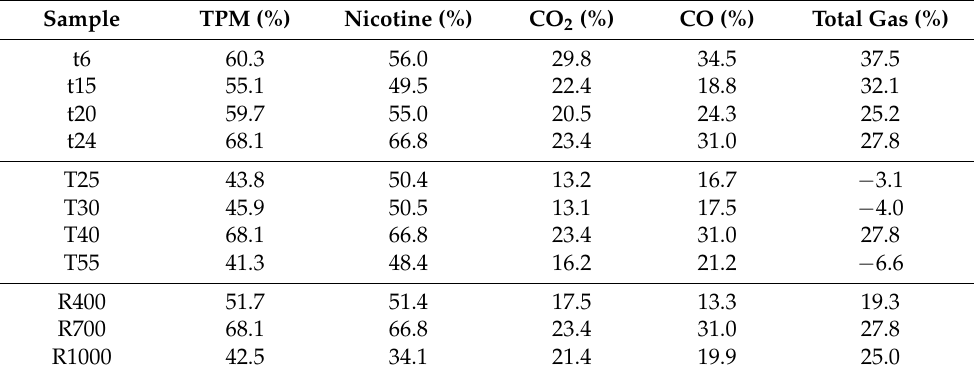
Table 2. Smoking experiments results. Reduction of total particulate matter (TPM), nicotine, CO 2 , CO and gases expressed in